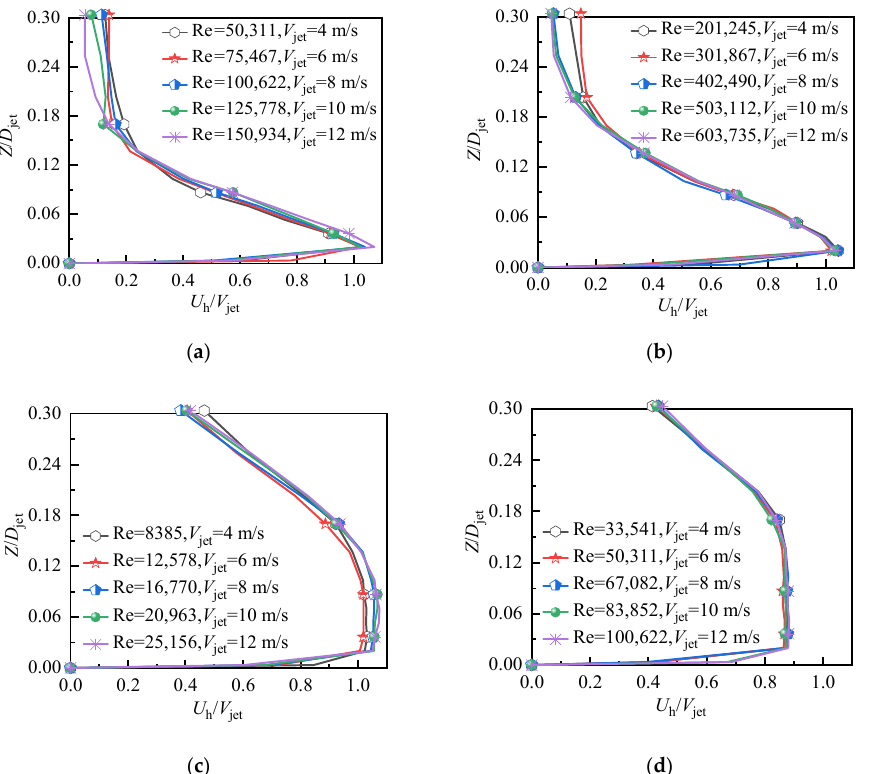
Figure 5. Profiles of horizontal velocity: ( a ) H1, crest; ( b ) H7, crest; ( c ) H6, hill foot on 135° ray; ( d ) H12, hill foot on 135° ray.